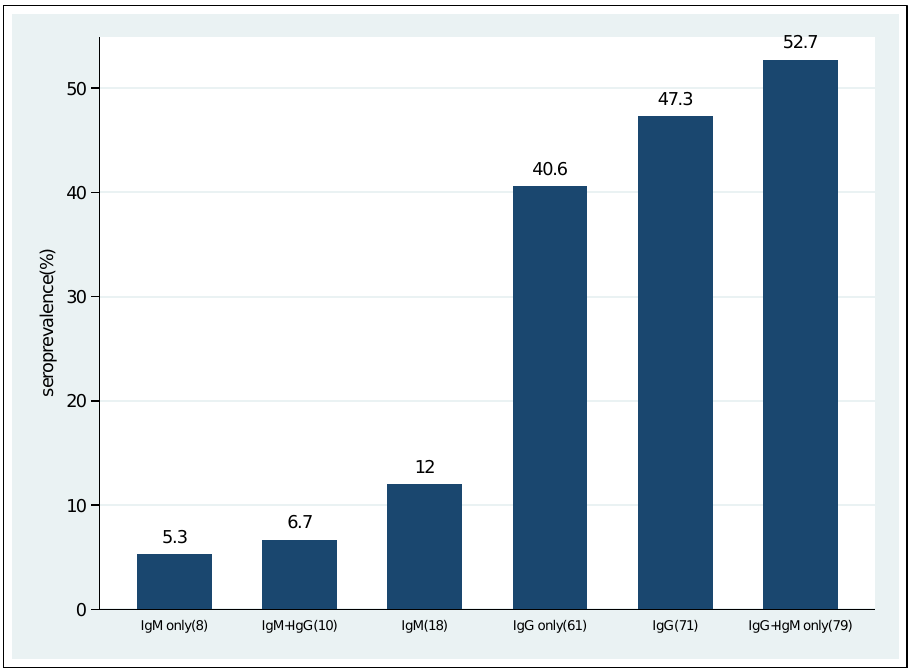
Figure 1. Seropositivity of SARS-CoV-2 antibodies among non-vaccinated HIV patients. 3.3. Factors Associated with Overall SARS-CoV-2 Seropositivity (IgG + IgM only) among HIV